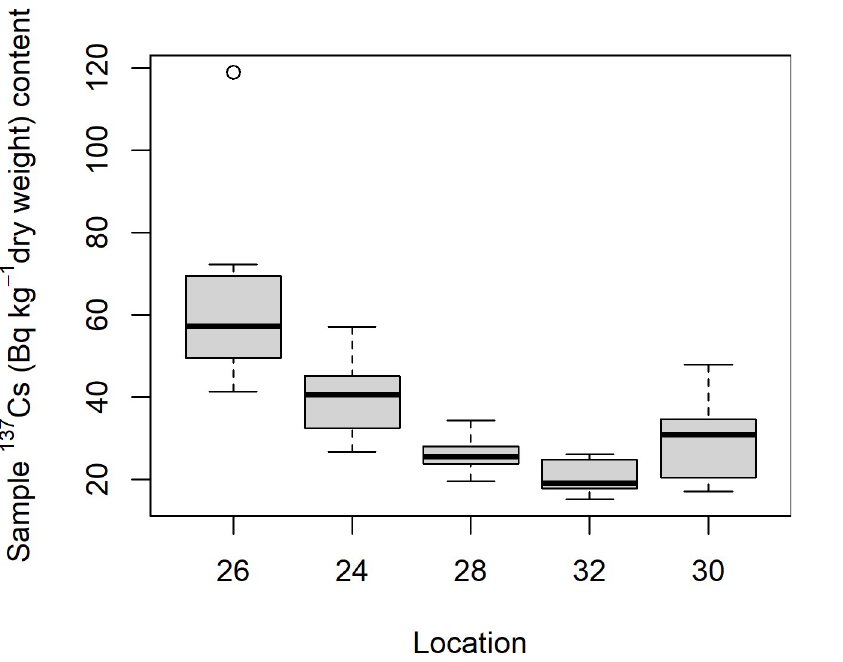
Fig 10. Boxplot of 137 Cs (Bq kg -1 d.w.) of soil samples among localities within Mining hill.